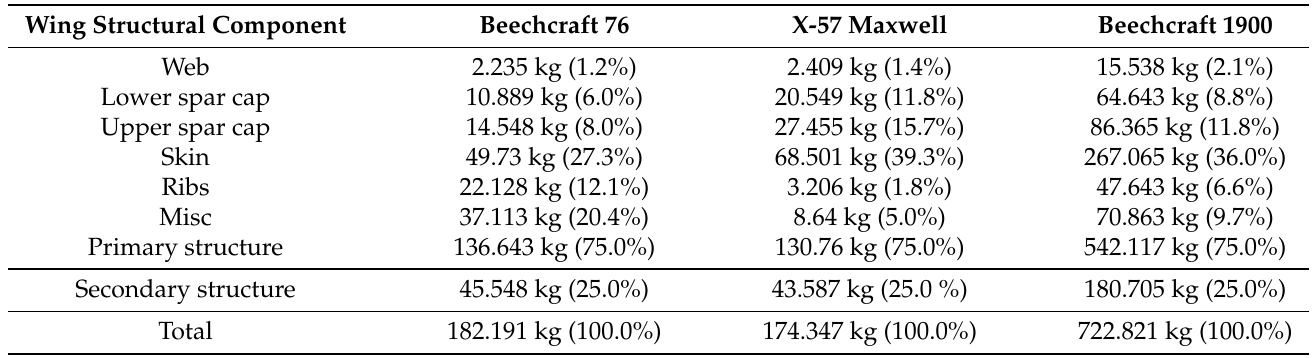
Table 3. Detailed mass breakdown (absolute and share of total wing weight) of the Beechcraft 76, the X-57 Maxwell, and the Beechcraft